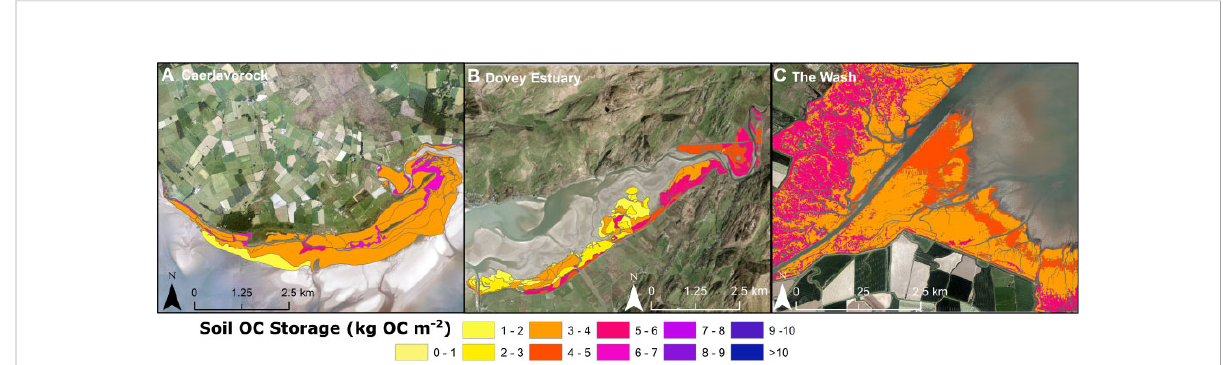
FIGURE 7 Examples of OC storage (kg OC m -2 ) mapped across (A) Scotland – Caerlaverock marsh (54.969555, -3.484984), (B) Wales – Dovey ( Dy fi ) Estuary (52.543454, -3.977258) and (C) England – The Wash (52.926668, 0.061452). Full geospatial dataset (Smeaton et al., 2022) can be found at: